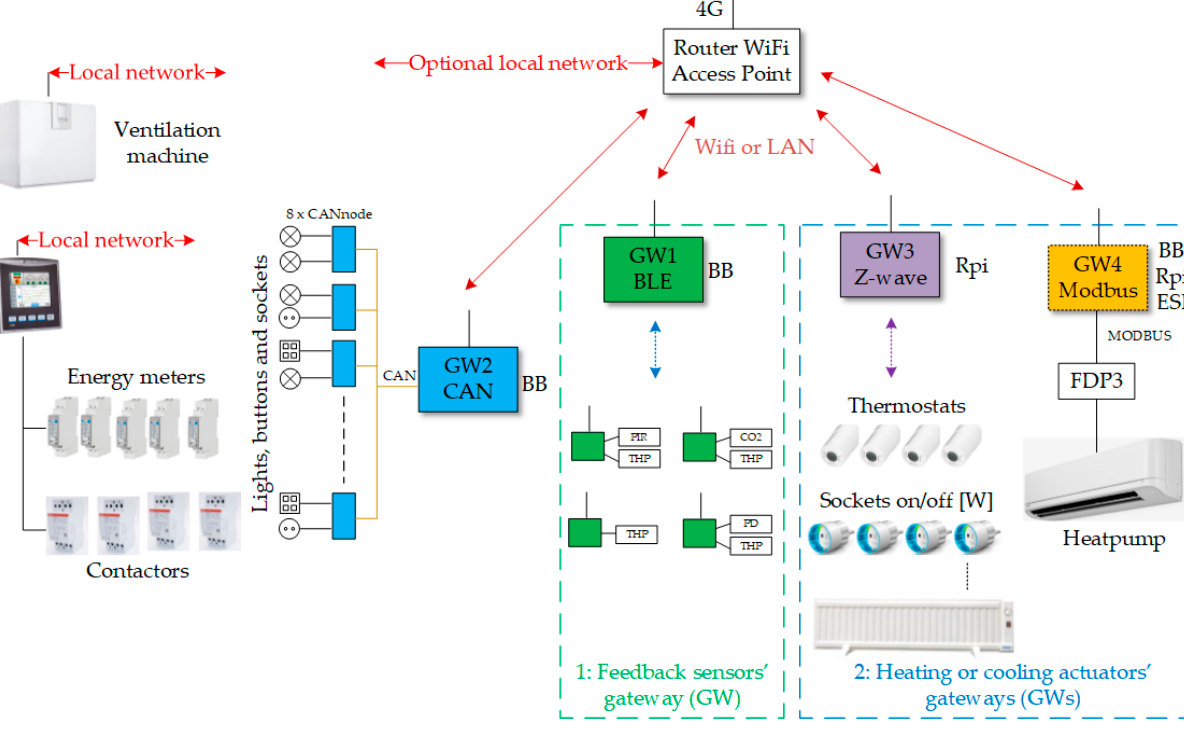
Figure 3. Sensing, metering, computing and communication hardware in residential load site of smart grid laboratory in Oulu.